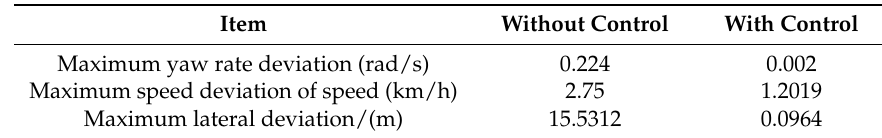
Table 6. Statistical control effect under F1 condition.